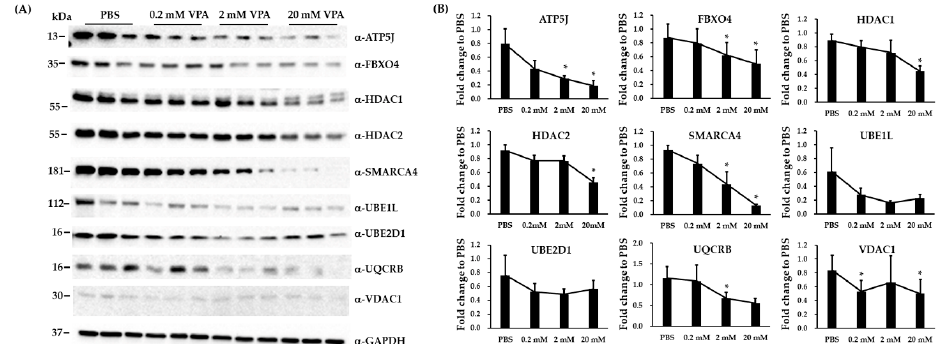
Figure 4. Immunoblotting analysis to validate the di ff erential expression for 9 proteins in VPA-treated and PBS-treated biological replicated SH-SY5Y cells. ( A ) Immunoblotting showed the expression of ATP5J, FBXO4, HDAC1, HDAC2, SMARCA4, UBE1L, UBE2D1, UQCRB, and VDAC17 in VPA-treated and PBS-treated SH-SY5Y cells. ( B ) Quantification showing the fold di ff erences in the expression of ATP5J, FBXO4, HDAC1, HDAC2, SMARCA4, UBE2D1, UQCRB, and VDAC1 between VPA-treated